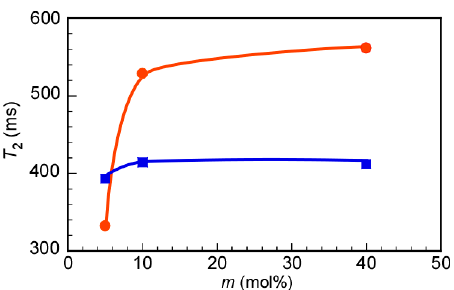
Figure 5. Spin–spin relaxation time ( T 2 ) for the pendant methyl protons in the MEA unit at 3.39 ppm ( ● ) and the MPC unit at 3.23 ppm ( ■ ) as a function of the MPC content ( m ) in P(MEA/MPC m ) in D 2 O at 25 °C.